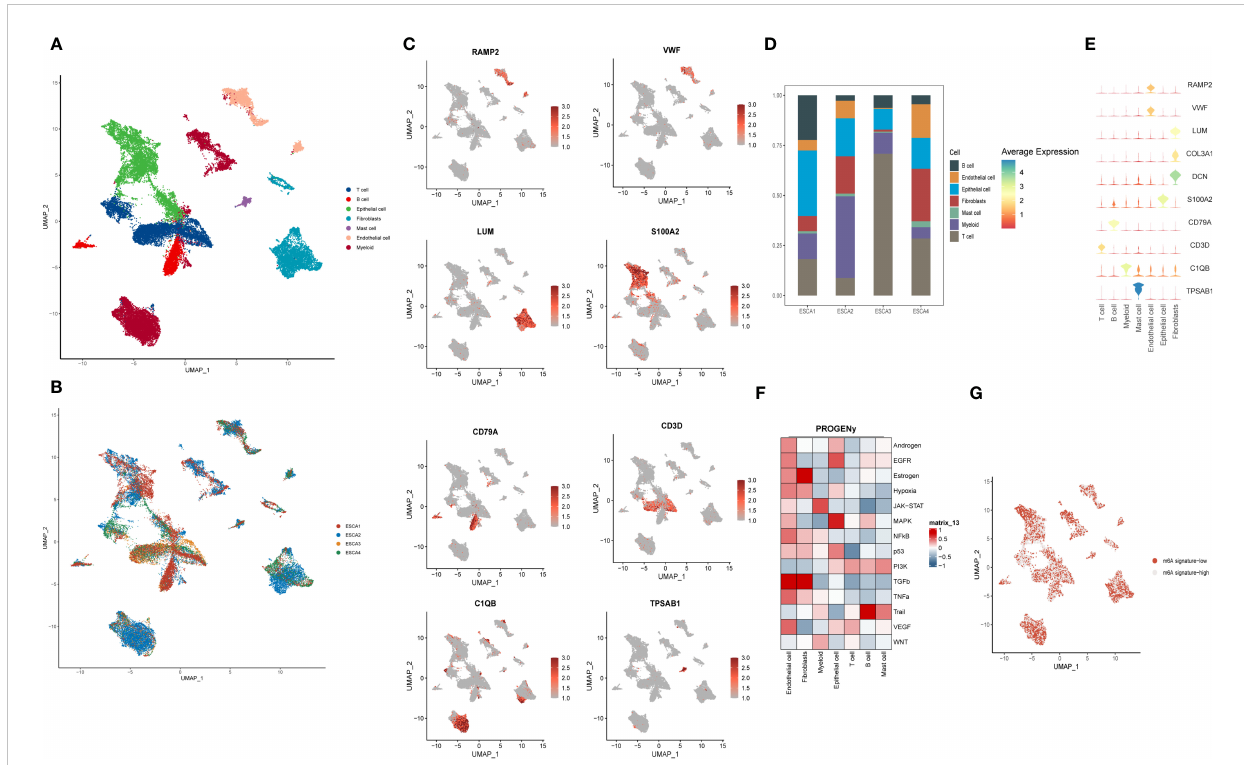
FIGURE 1 Spatial depiction of single-cell sequencing data and annotation of immune cell types and gene distribution in ESCC patients. (A) U-MAP plot showing the sample source of the single-cell data, with each colour representing one sample, including a total of 4 patients; (B) Representative 7 major immune cell types and distribution annotations in ESCC cells, including T cells, B cells, epithelial cells, fi broblasts, mast cells, endothelial cells and myeloid cells; (C) Single-cell sequencing obtained from 7 cell types in the major m6A gene cluster expression distribution maps, including RAMP2, VWF, S100A2, LUM, CD79A and CD3D. outlines the spatial distribution of expression of their major immune cell types. (D) Scale bar graphs further analyze the distribution of immune cell types in four different ESCC patients; (E) Bubble plots further visualize the major m6A